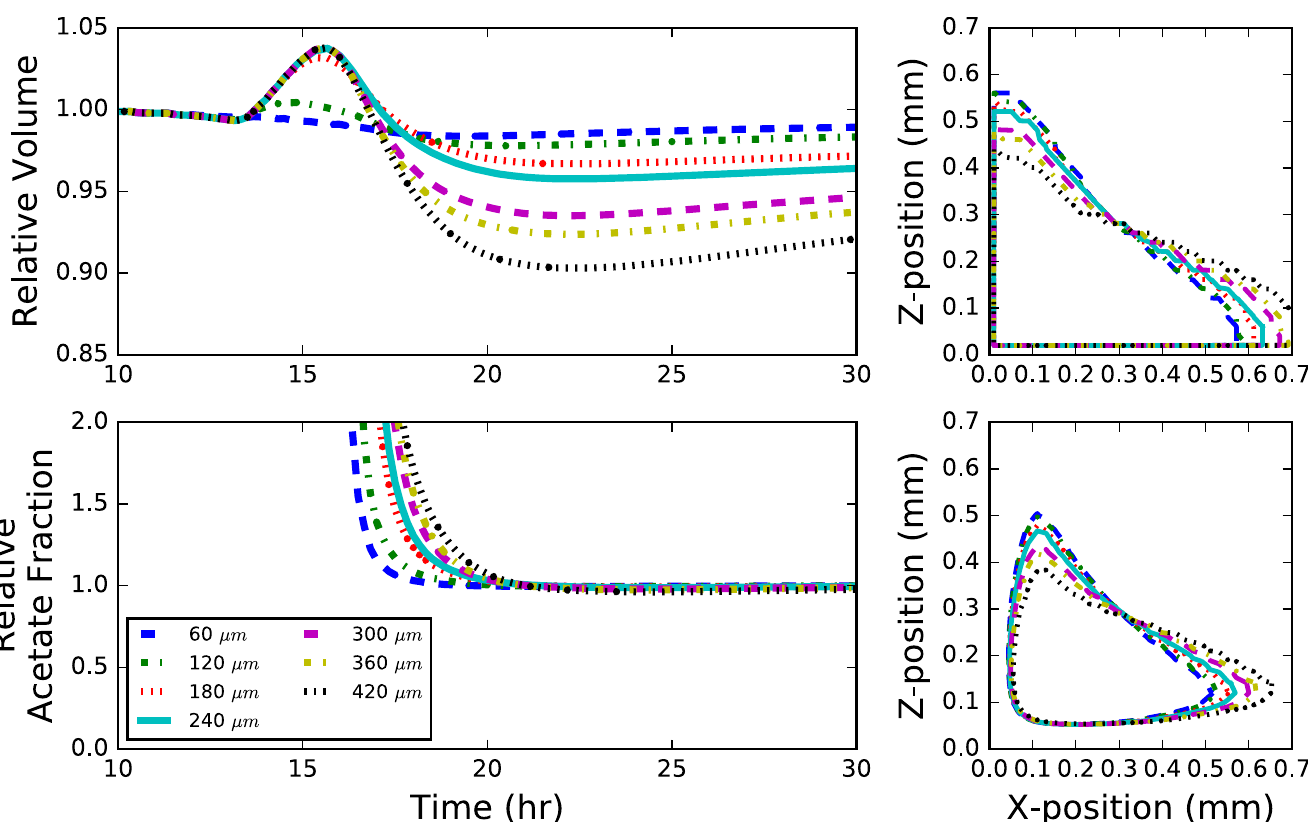
Fig 7. Wall geometry. Behavior of E. coli coloniesgrown next to an agar wall containing metabolizable glucose.Different curves indicate the distanceof the initial colony seed from the wall. Coloniesgrown further from the wall generallygrow slower than coloniesseedednear the wall, howevertend to grow more quickly when they interact with the wall as demonstrated by an inflection in each curve (top left). The fraction of acetate utilizers in a community linearlyon the distancefrom the wall (bottom left). A profile the colony showingthe acetate utilizingfraction (contourlevel = 0.05; bottom right) and the wholecolony (contour level = 0.64; top right) after 25 hours of growth. Colonyvolume and acetate fraction are shown relative to a colony that begangrowth at the edge where the wall meets the floor.